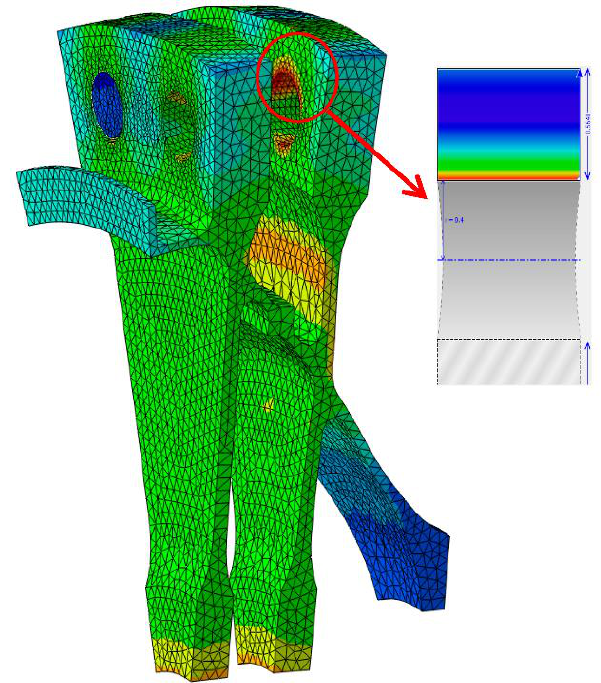
Figure 11. Representative geometry has maximum principal stress of 965 MPa located on the bolt